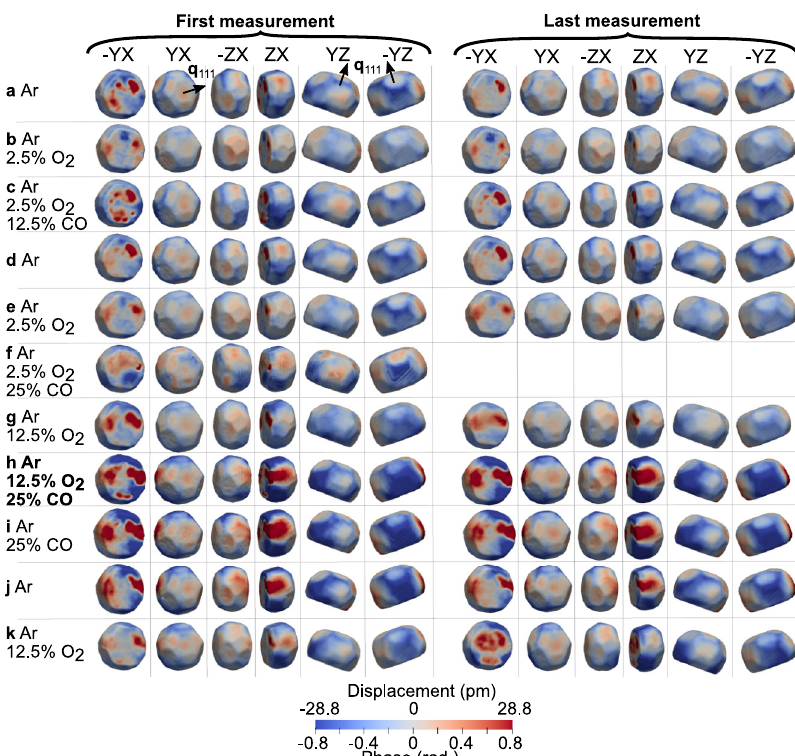
Fig. 2 In situ 3D lattice displacement images during reaction for NP300. Evolution of BCDI reconstructions of the displacement fi eld and phase along the [111] direction, drawn at 50% (see Supplementary Fig. S6 for the choice of this value for the isosurface) of the maximum Bragg electron density of NP300 at 450 ∘ C and for different gas mixtures (CO oxidation reaction under stoichiometric conditions is indicated in bold). The left (right) panel, which corresponds to the fi rst (last) measurement, shows the particle at the beginning (end) of the corresponding gas mixture: a Ar, b Ar + 2.5% O 2 , c Ar, 2.5% O 2 + 12.5% CO, d Ar, e Ar + 2.5% O 2 , f Ar + 2.5% O 2 + 25% CO, g Ar + 12.5% O 2 , h Ar + 12.5% O 2 + 25% CO, i Ar + 25% CO, j Ar and k Ar + 12.5% O 2 . The “ last ” measurement has been taken after reaching the saturation of the changes. It corresponds to the steady state of the particle. Note that the crystal is represented in the laboratory frame, which explains the observed 20 ∘ tilt corresponding to the incidence angle of the incoming x-ray beam. In addition, because of the representation in the laboratory frame, X, Y, and Z do not correspond to any particular crystallographic direction. The direction of the scattering vector q 111 from several points of view is indicated for some images of the top row (condition a ). During condition f only a single measurement was taken and is thus